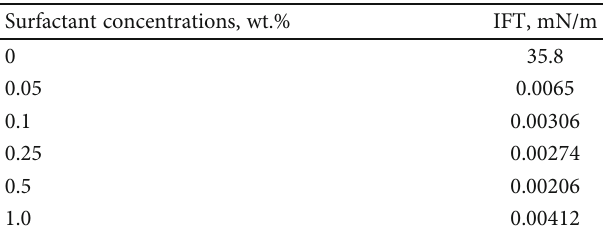
Table 3: The rock and fl uid properties used in the